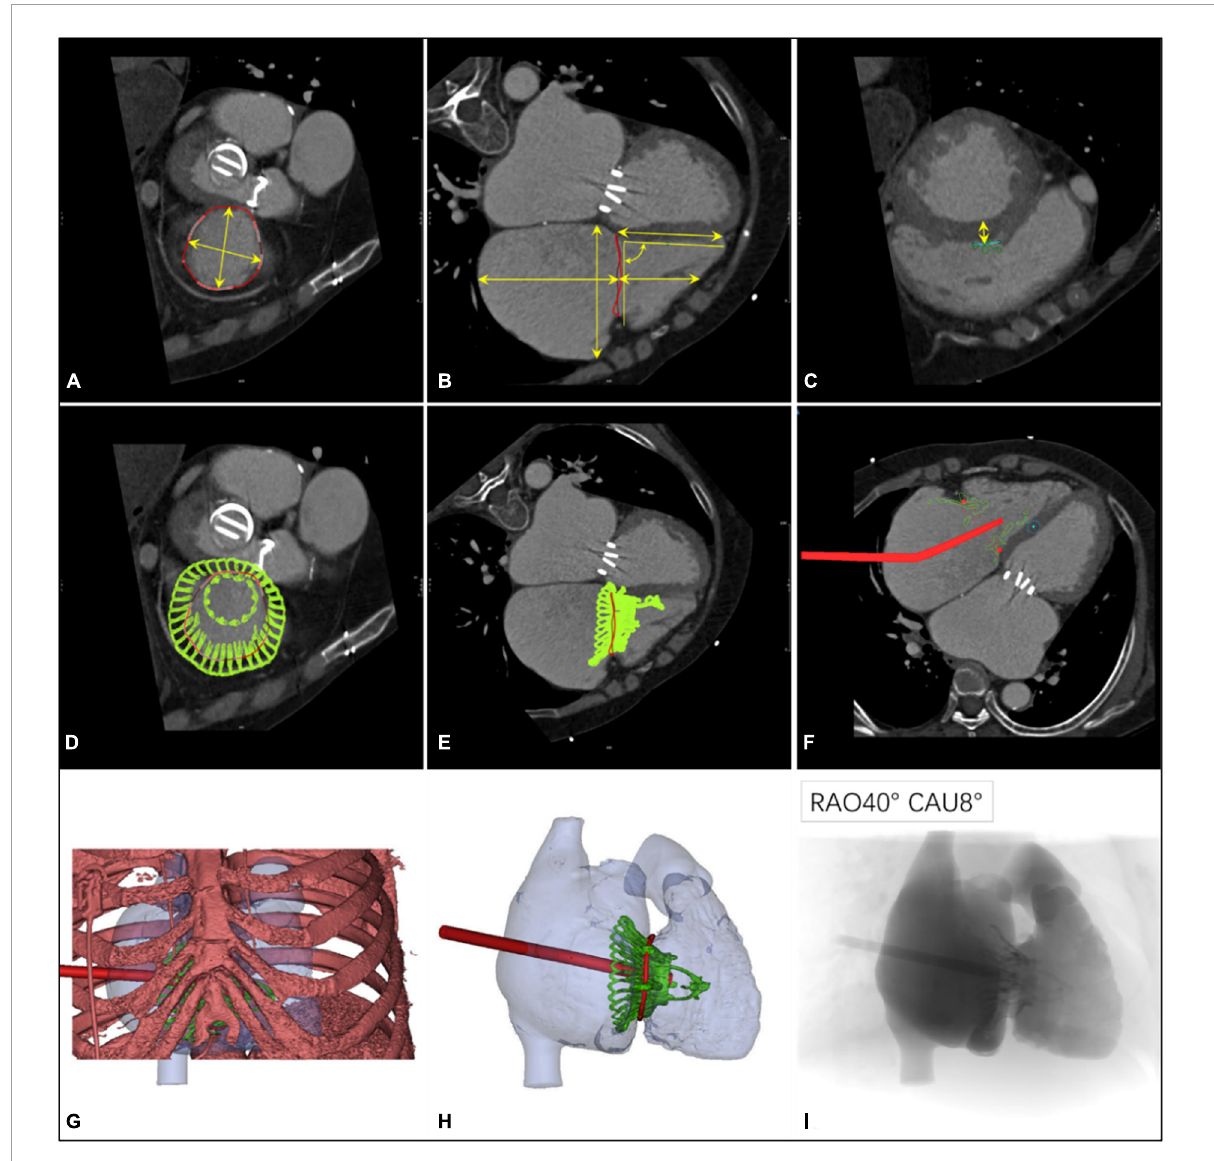
FIGURE1 Preprocedural computerized tomography angiography assessment of transcatheter tri-cuspid valve replacement. (A) The diameter and perimeter of the tricuspid annulus (TA) were determined. (B) Measurements of the distance from the septal valve to the apex of the right ventricle, the height of the right atrium, and its relationship with the TA; the angle between the TA and the ventricular septum was 90 ◦ ± 10 ◦ . (C–E) Computer simulation of the LuX-Valve implant to observe the location of the anchor points and to measure the thickness of the ventricular septum in this position (30 mm below the TA). (F) Materialize Mimics 21.0 software (Materialize, Leuven, Belgium) was used to analyze the position and the angle of the delivery system on a 2-dimensional image. (G) The position of the right intercostal incision was determined with a digital 3-dimensional image. (H) The shape and the release position of the LuX-Valve were observed using 3-dimensional virtual models. (I) Simulation using fluoroscopic images provided an ideal projection angle for the transcatheter tricuspid valve